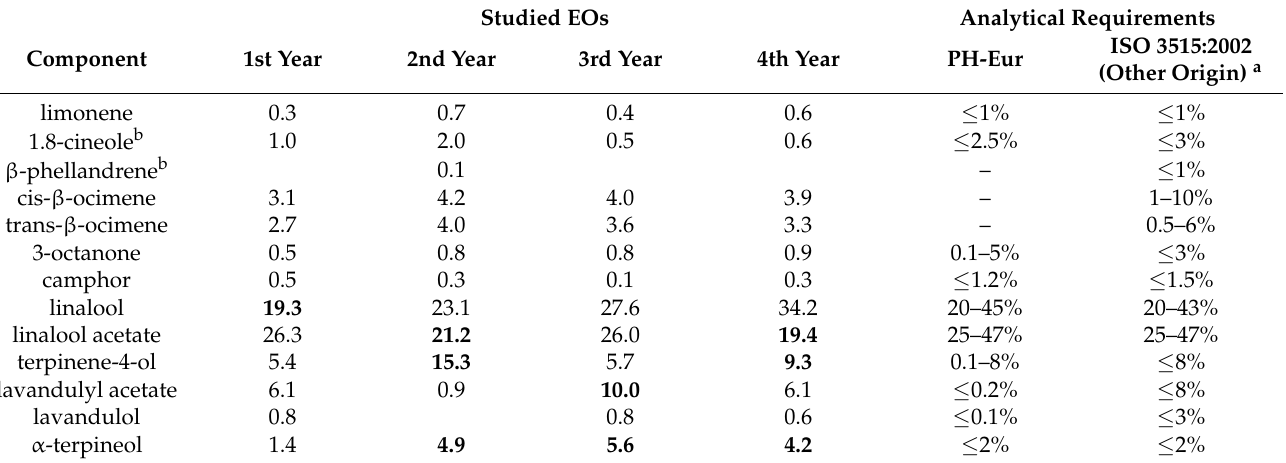
Table 2. Comparative requirements for L. angustifolia essential oil according to the Ph.Eur. (10th Ed.) and ISO